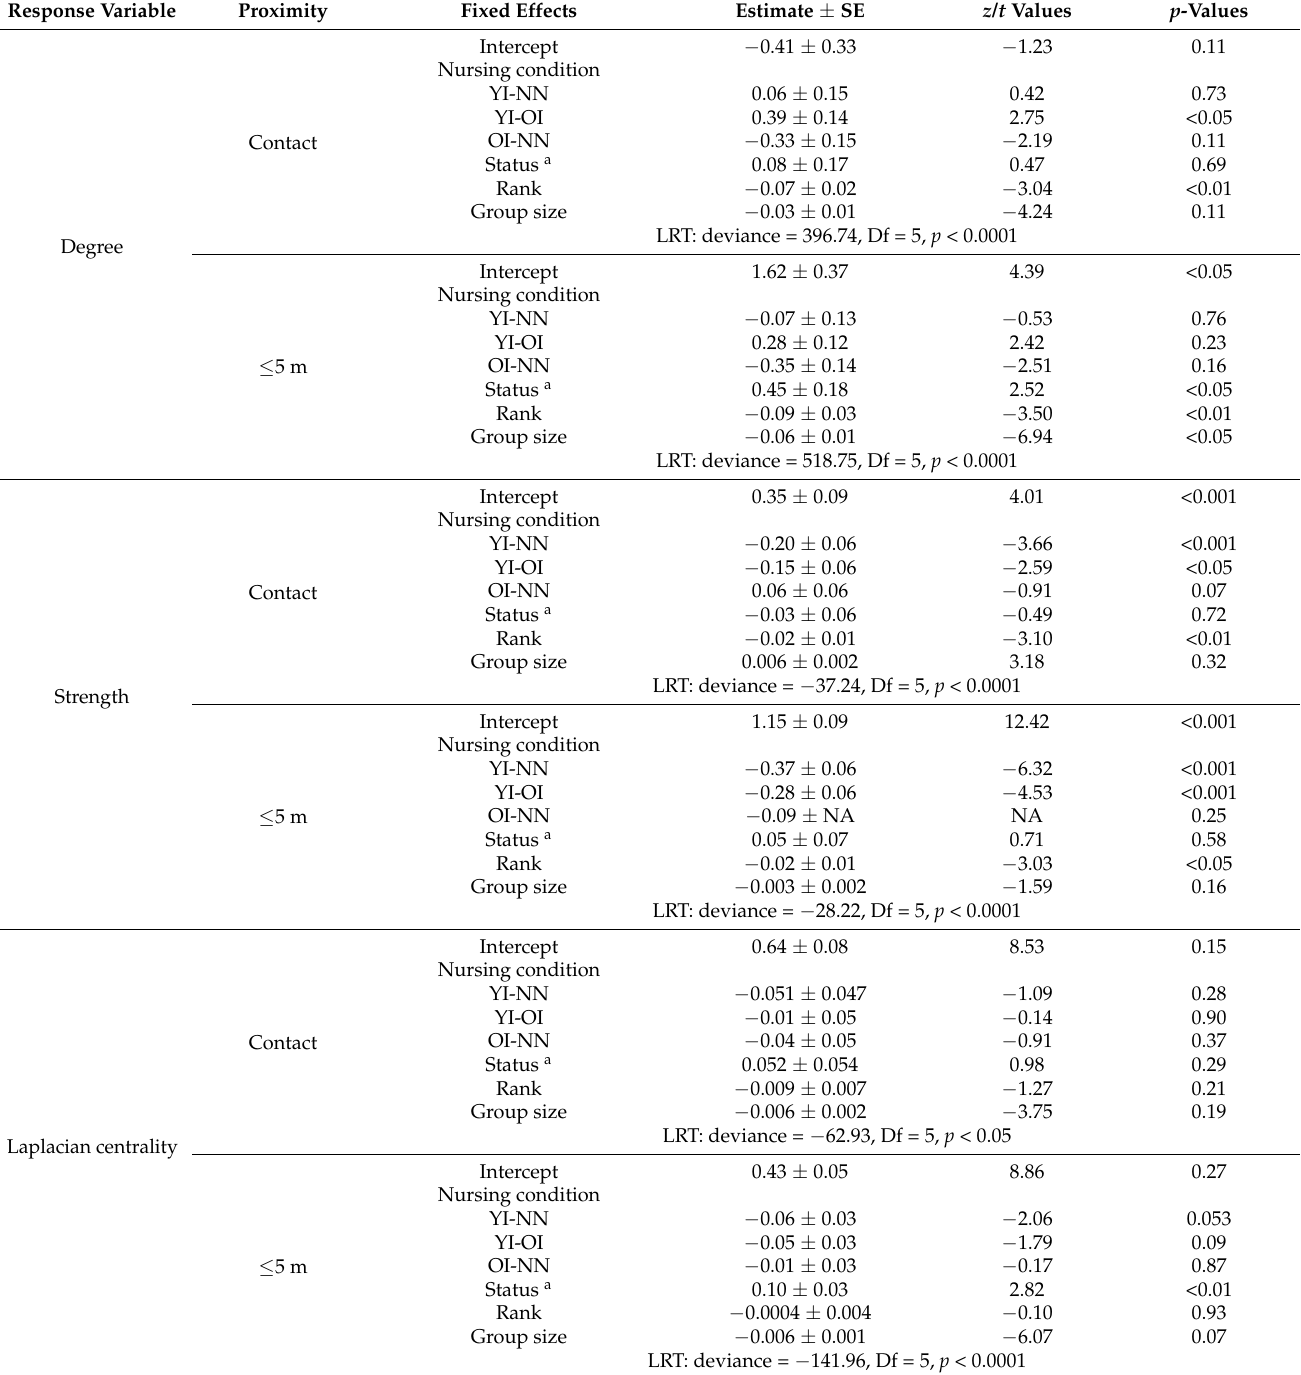
Table 1. Proximity network. Generalized linear mixed models (mixed binomial (degree) or gaussian (strength and Laplacian centrality) regressions) of SNA proximity (contact or ≤ 5 m) metrics, testing the main fixed effects of nursing condition (YI vs. OI vs. NN females), and the controlled predictors (i.e., fertility status (intact vs. sterilized females), group size and hierarchical rank): coefficient estimates, standard errors, z -test (for degree), or t -test (for strength and Laplacian centrality) and p -values, and likelihood ratio tests (LRT). The reference category for the nursing condition is the first condition stated. a “Intact females” as a reference category for the fertility status. The lowest values of the hierarchical rank represent the highest-ranked